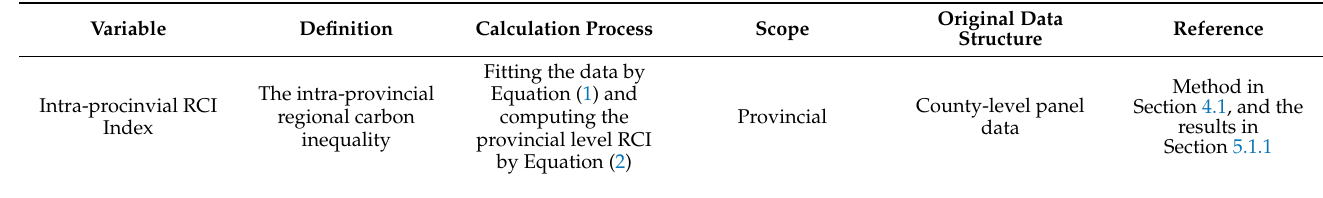
Table 4. Descriptions of the variables used in this